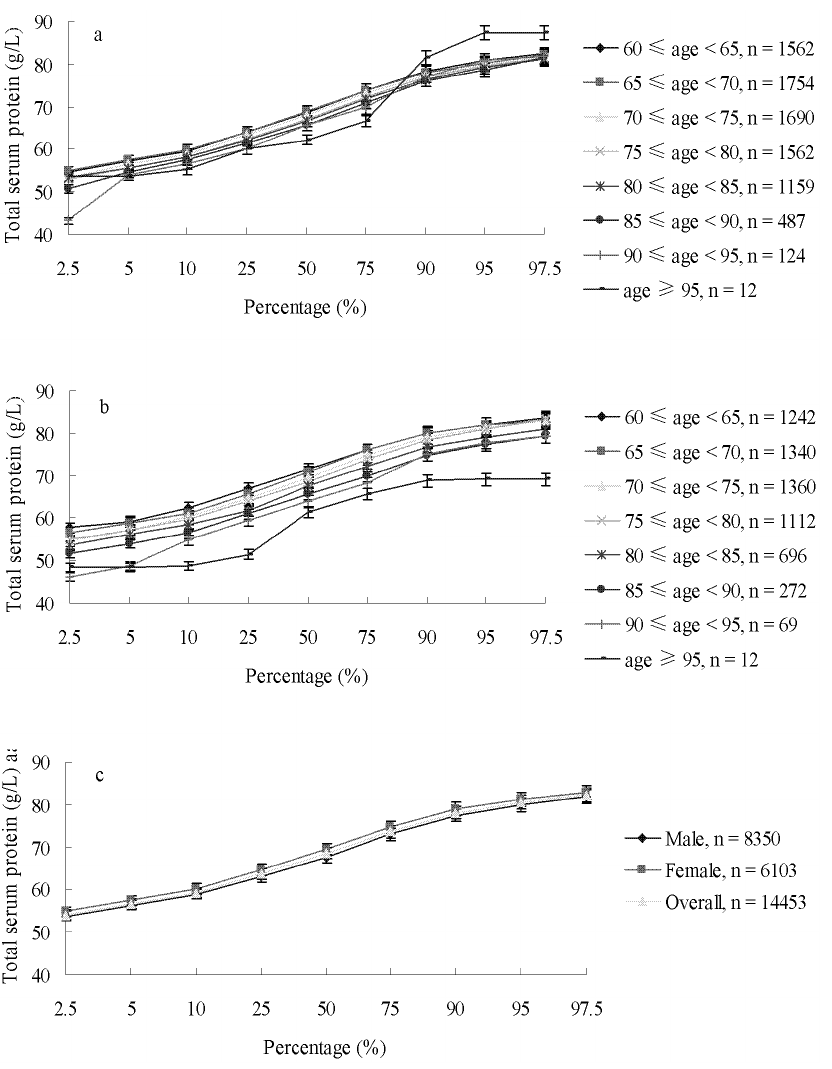
Figure 1. The percentage distribution of serum total protein in male (a), female (b), and total (c) groups aged $ 60.